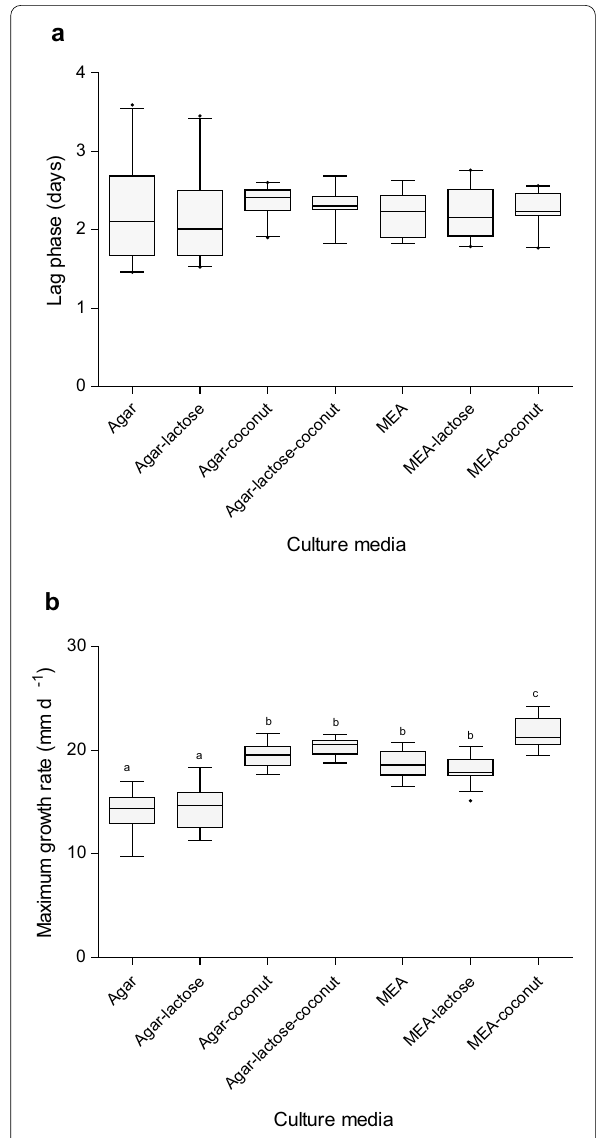
Fig. 4 a Lag phase of M. esculenta CDBB‑H‑482 and isolate FRE‑3C according to culture media. b Growth rates of M. esculenta CDBB‑H‑482 and isolate FRE‑3C according to culture media. Different letters indicate significant differences according to Duncan test ( p < 0.05, n =